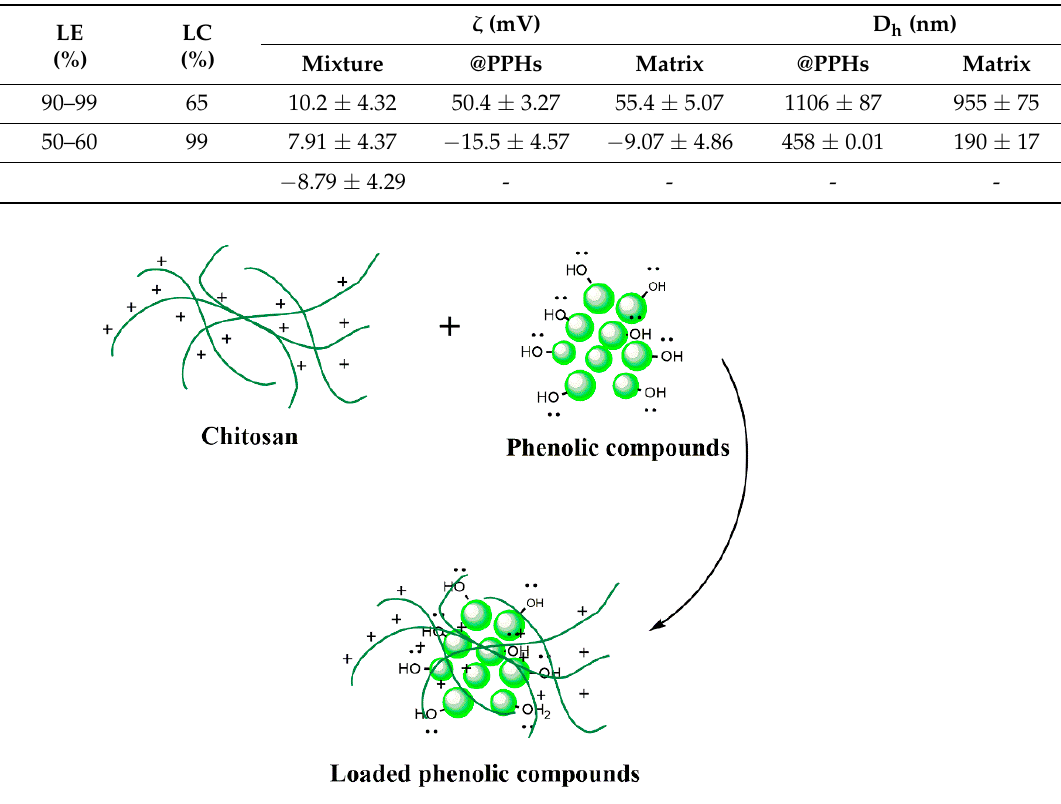
Table 3. Loading Efficiency (LE) and Loading Content (LC) of PPHs in polymer matrixes; zeta po- tential ( ζ ) and particle sizes of loaded (@PPHs) and unloaded (Matrix) polymer matrixes. Values represent the mean ± standard deviation (n = 3).